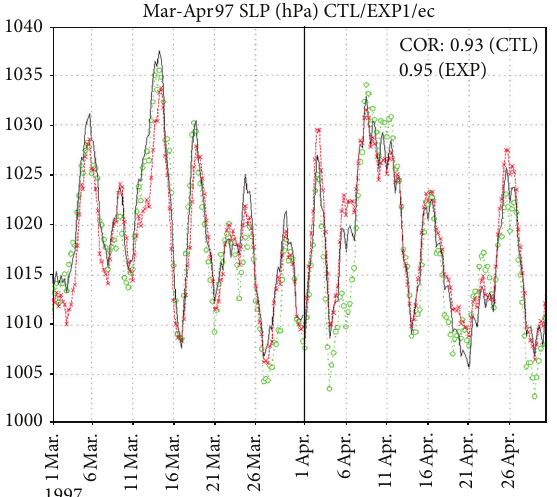
Figure 4: Time series of mean sea-level pressure [hPa] for ECMWF (green circle), CTL (red cross), and EXP1 (solid line) simulations in box 2 of Figure 1.